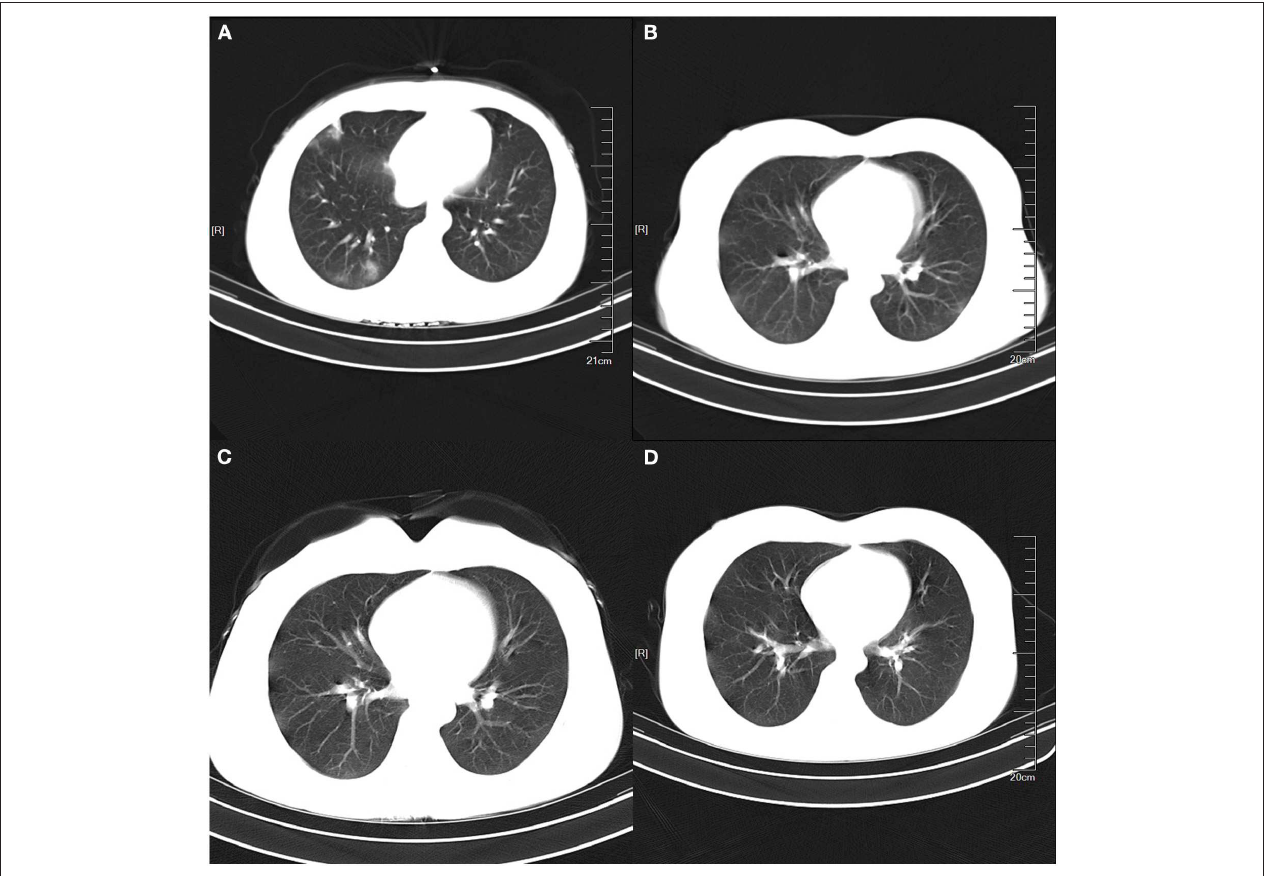
FIGURE 2 | The specific Chest CT scans of the re-positive patient at different periods. (A) was the multiple patchy high-density shadow on bilateral lungs at admission; (B) was the patchy low-density shadows at first discharge, which was significantly better than that of admission; (C) showed patchy low-density shadows in the right lower lobe at the first follow-up visit; and (D) showed no abnormal high-density shadows at second